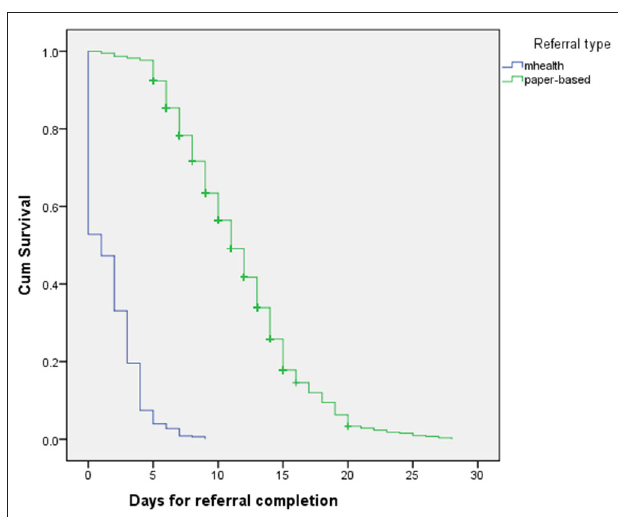
FIGURE 1 | Time to referral completion for mHealth and paper-based